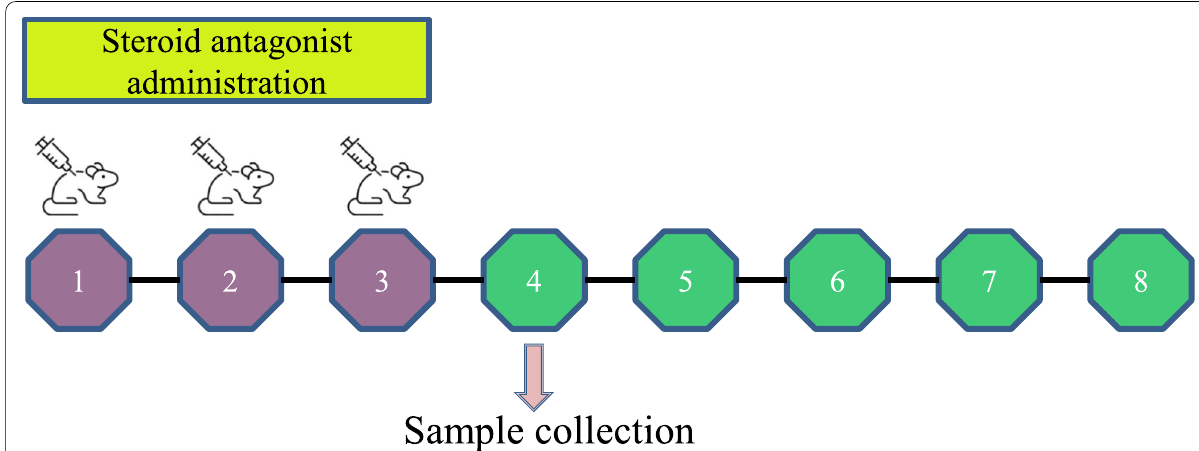
Fig. 1 Schematic representation of ovarian steroid antagonist administration regimen. Antiestrogen (100 μg/100 μl), antiprogesterone (200 μg/100 μl), and antiestrogen antiprogesterone (100 200 μg/100 μl) injected subcutaneously from D1 to D3 in 3 different groups. Uterine tissue + + samples were collected on D4 at 0900